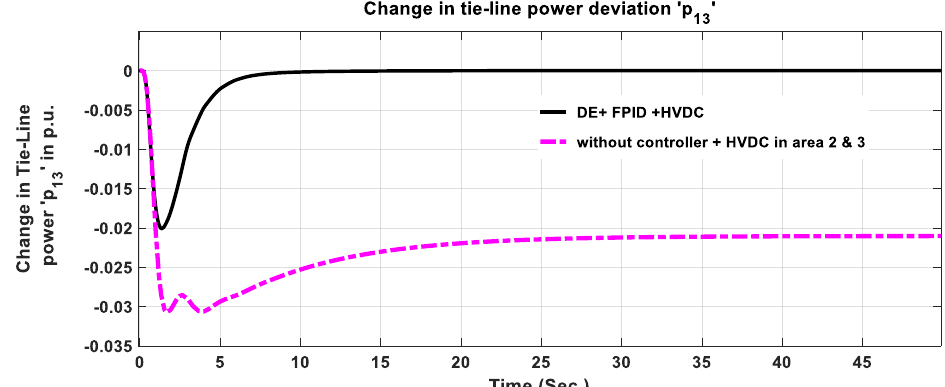
Figure 10. Comparison of controller and without controller for change in ACE 3.